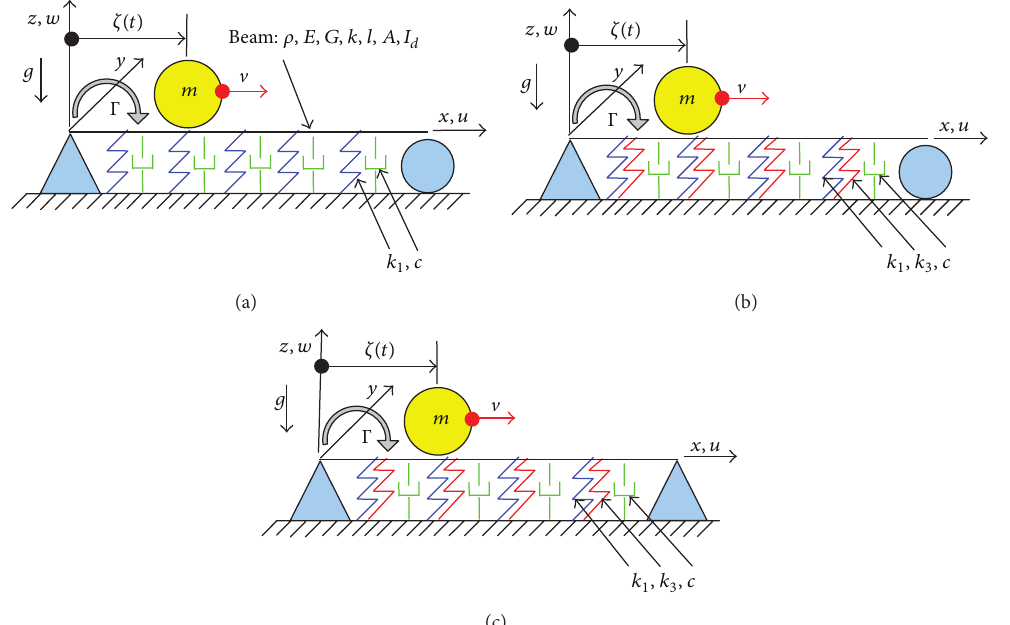
Figure 1: Timoshenko beam under the motion of a concentrated point mass resting on a viscoelastic foundation. (a) Timoshenko beam with no stretching effect on simply supported ends resting on a linear viscoelastic foundation, M-1 model, (b) Timoshenko beam with no stretching effect on simply supported ends resting on a nonlinear viscoelastic foundation, M-2 model, and (c) Timoshenko beam with stretching effect on pinned-pinned ends resting on a nonlinear viscoelastic foundation, M-3